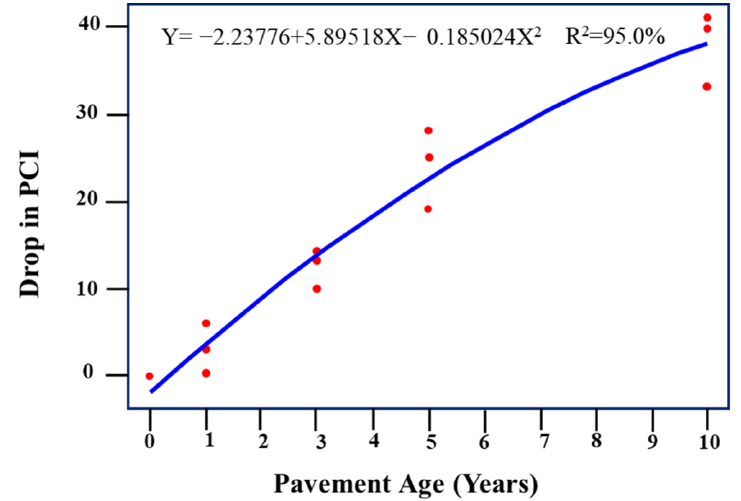
Figure 6. Effects of the no maintenance strategy on the deterioration of PCI for high traffic.